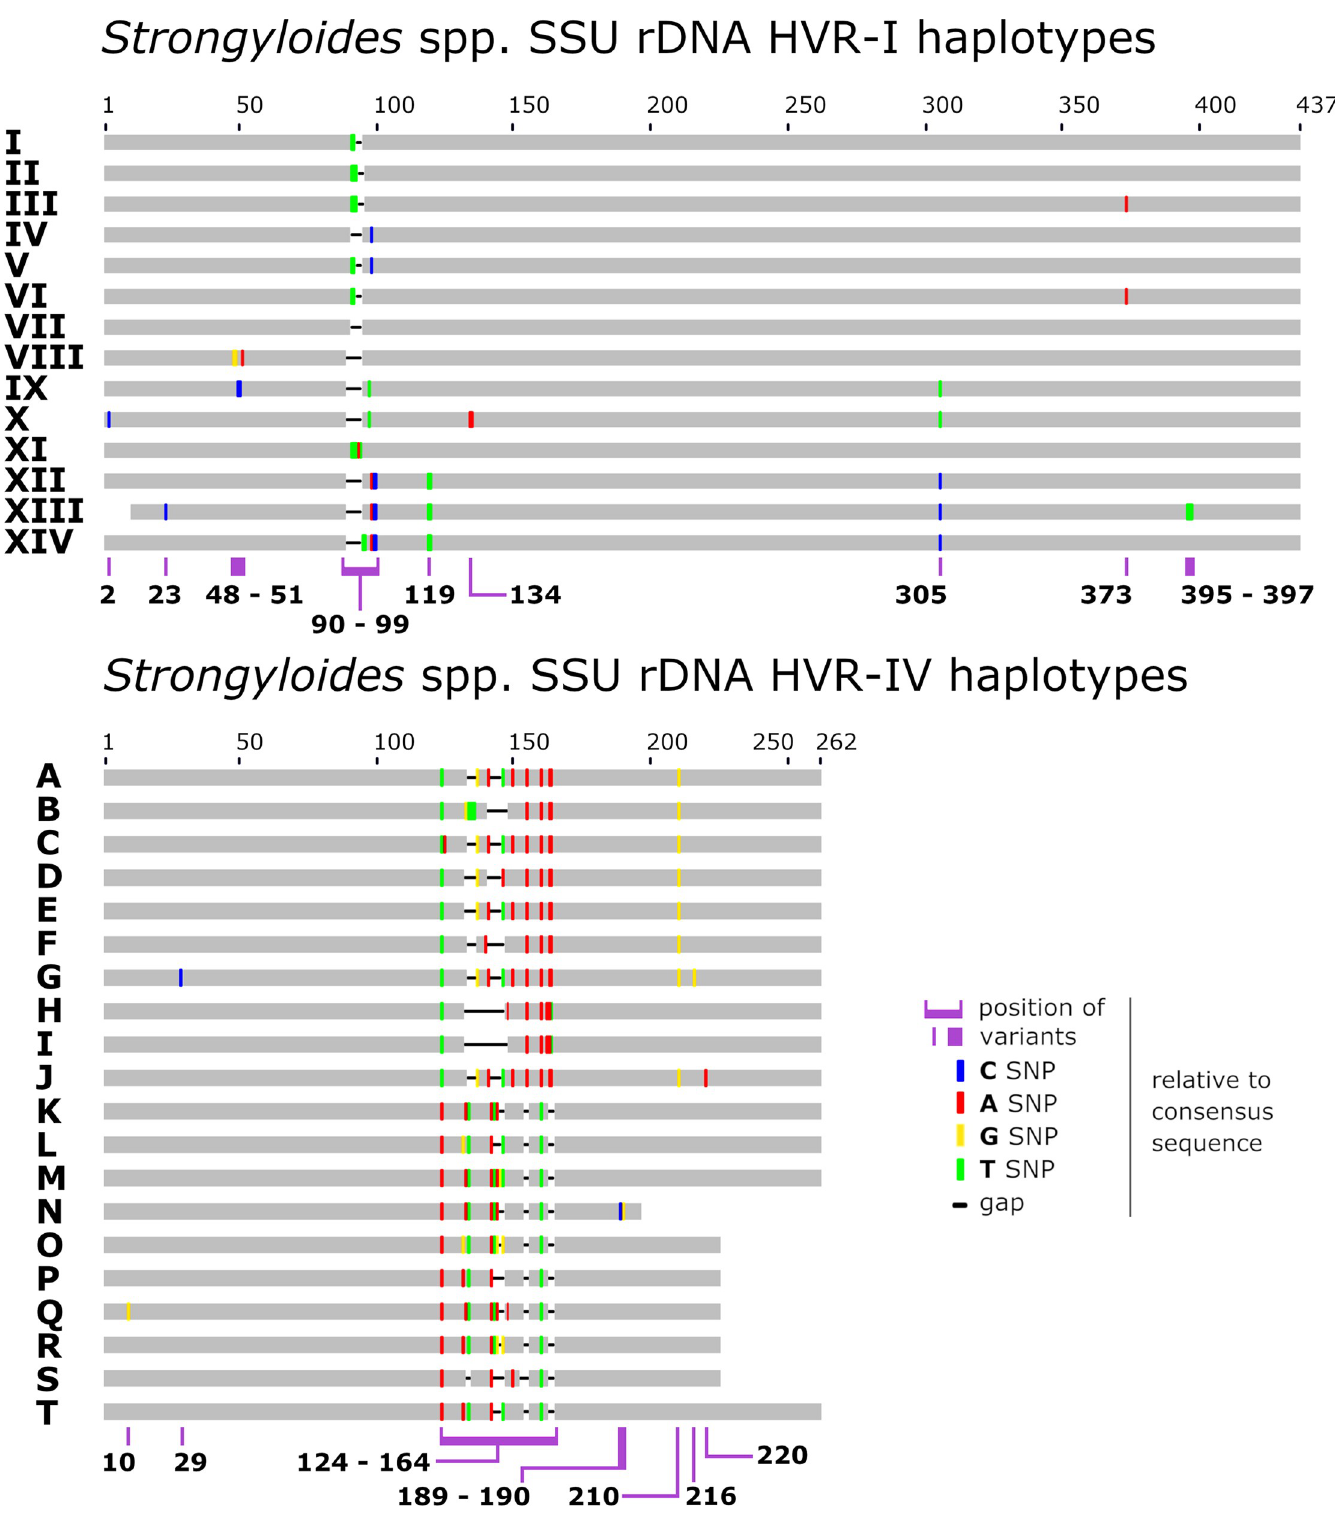
Fig 1. Schematic of the Strongyloides spp. genotyping scheme. A graphical representation of the Strongyloides spp. genotyping scheme described previously [21], expanded to include additional genotypes from S . stercoralis and S . fuelleborni . This scheme includes novel sequences identified in this study and 18S sequences available in GenBank (GB), where the appropriate 18S HVR-I and/or HVR-IV regions were captured. Sequences from GB possessing Ns or ambiguous bases were excluded from the scheme. For additional details on the hosts in which these Strongyloides spp. haplotypes were detected, refer to Tables 2 and 3.